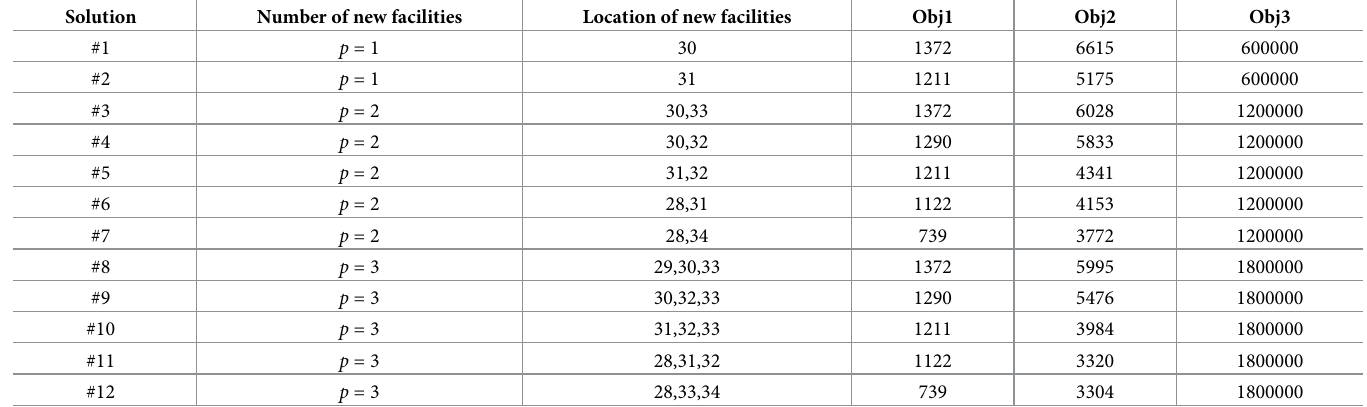
Table 3. The corresponding scheme and objective function value of Pareto optimal solution of Model 1.